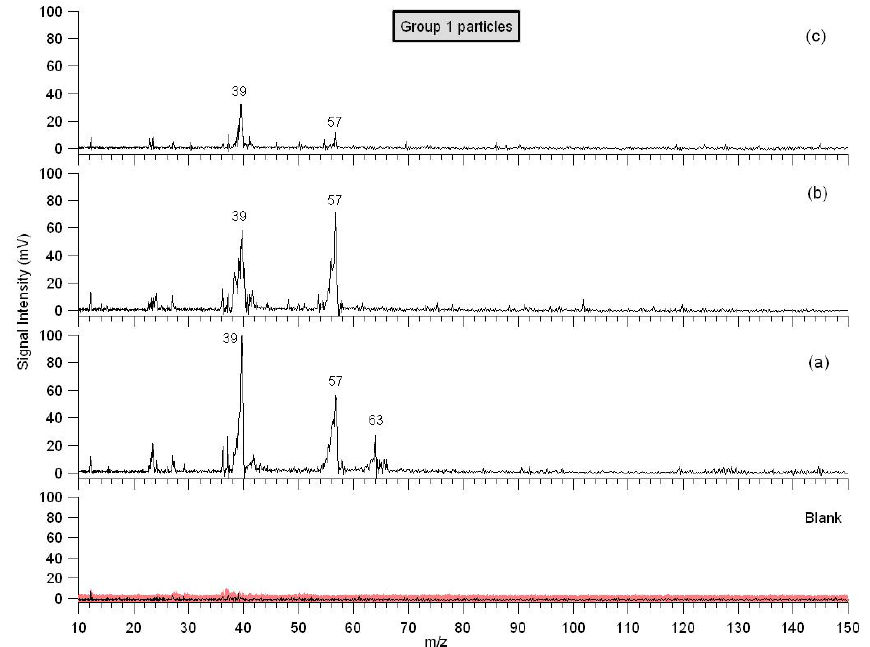
Fig. 9. Blank: typical noise level on the mass spectra obtained for a single laser pulse (SPLAM inlet open, CESAM chamber filled with synthetic air and ozone but without indene). The blank level is determined to be at 4mV (indicated as red shaded zone). See text for further explanations; (a) , (b) , (c) : examples of three single particle mass spectra of SOA produced by ozonolysis of indene in the smog chamber CESAM (group 1